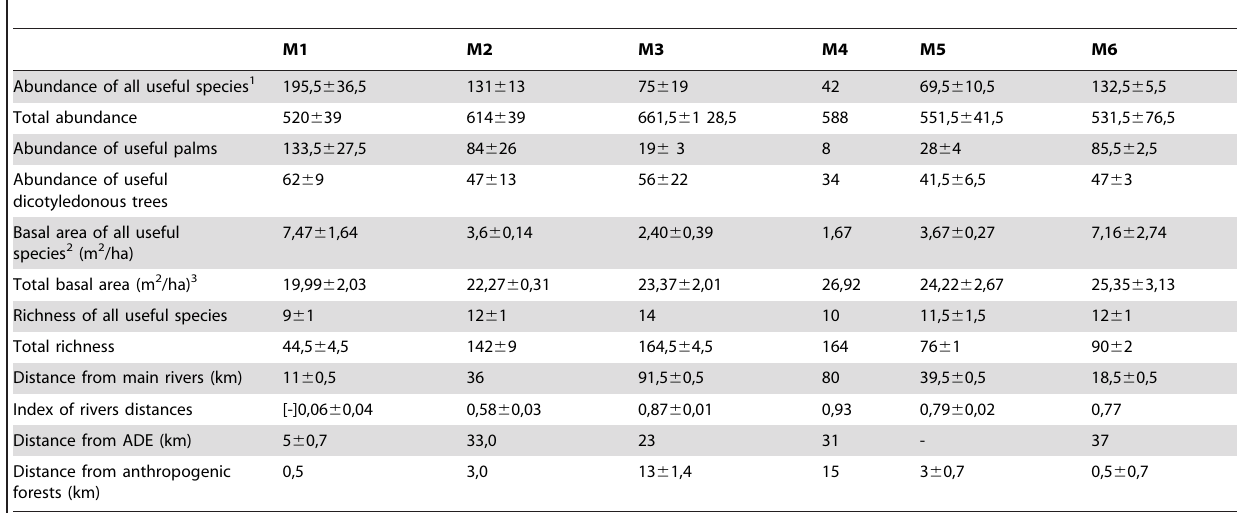
Table 1. Means and standard deviations of all botanical data and distances measured in the six study sites along the Purus- Madeira interfluve, Amazonas, Brazil.